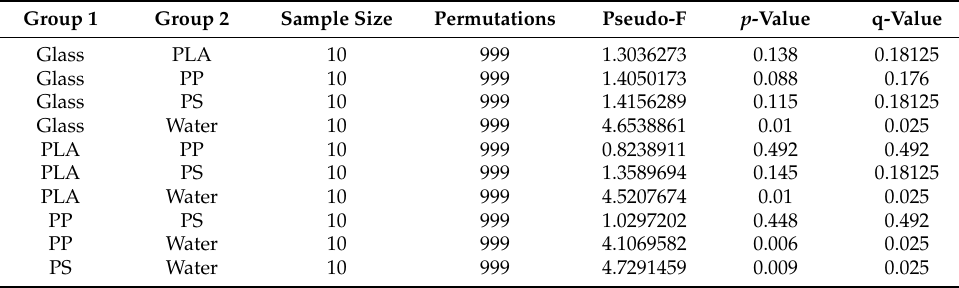
Table 2. Group significance PERMANOVA in a pairwise